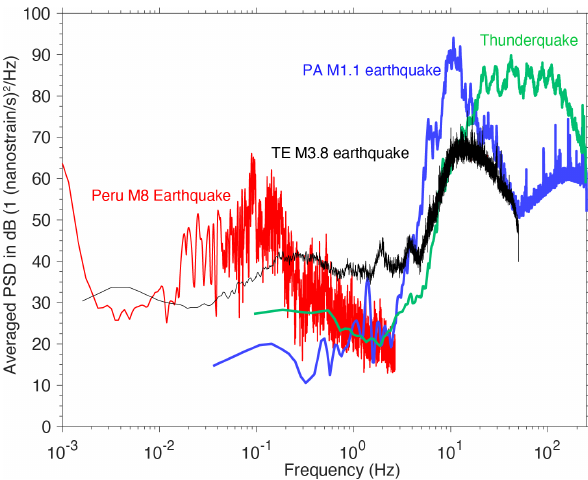
Figure 8. Averaged power spectral density of DAS recordings of earthquakes and